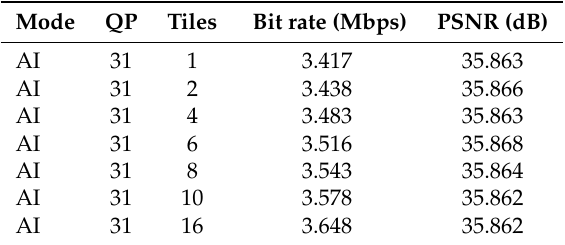
Table 6. Bit rate and PSNR for AI for different tiles per frame